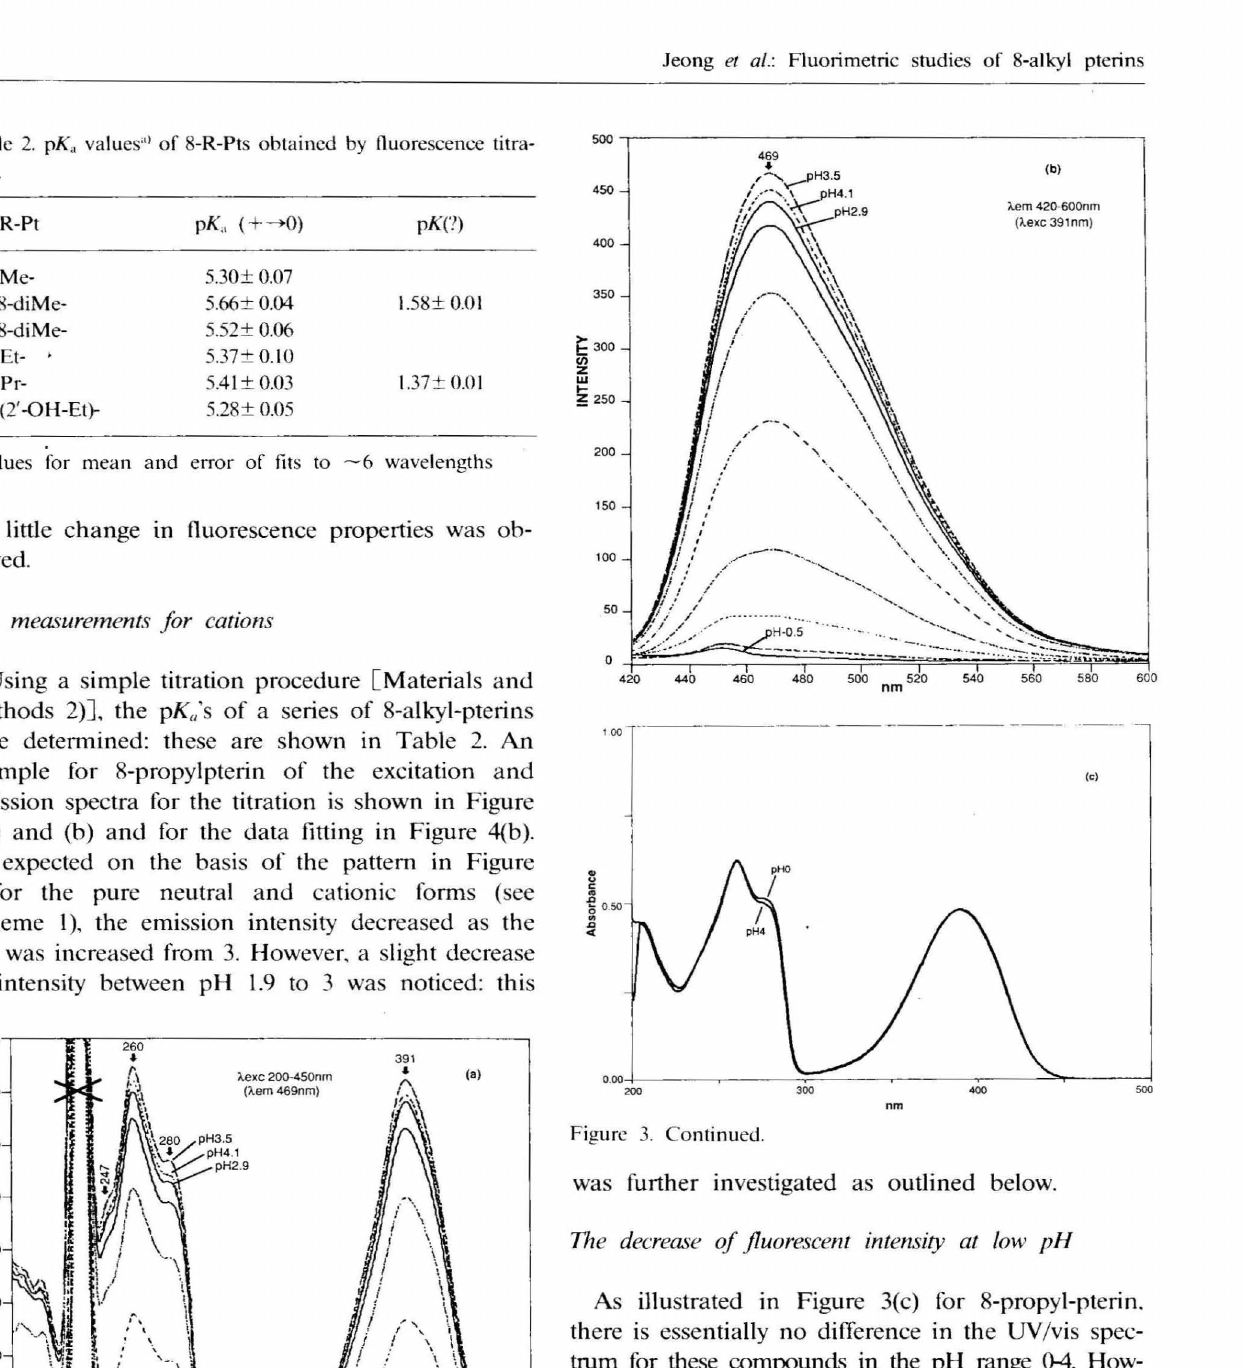
Figure 3. Excitation (a) and emission (b) spectra lor the titra tion between pH - 0.5 and 4 of 8-propyl-pterin. Concentration is 1.6 f.lM. X are spectral artifacts. Intensity values were tilled at 247. 260. 2S0. 391 and 469 nm to calculate an apparent ionization value shown in Table 2. (c) UV /vis spectra at pHs O. I. 2. 3 and 4 I'or concentration -45 flM. Pteridines / Vol. 4 I No.